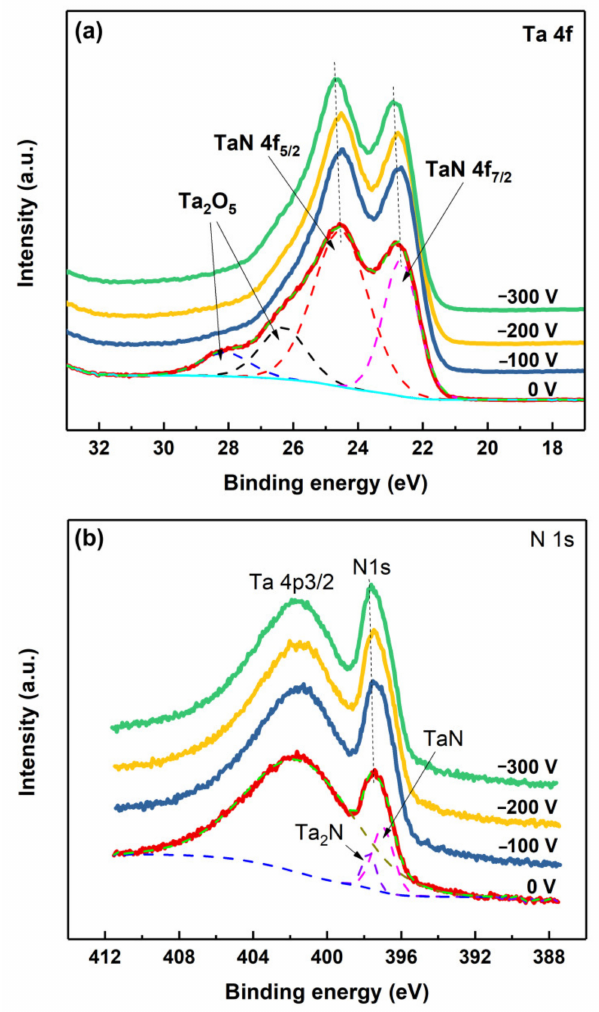
Figure 4. High resolution XPS spectra of the Ta 4f ( a ) and N 1s ( b ) of the TaN x coatings deposited at different bias